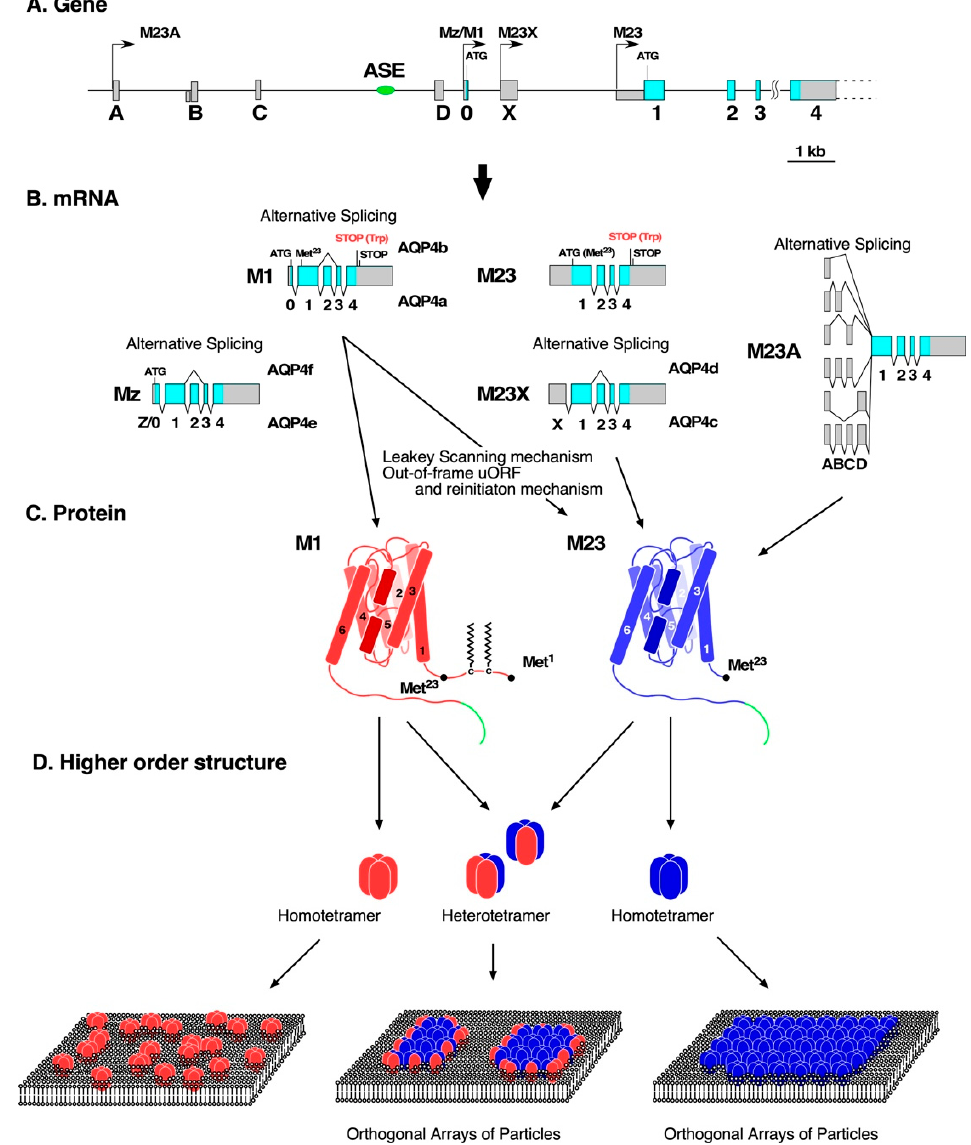
Figure 1. Characteristics of AQP4 expression, translation, and expression on the cell surface. ( A ) A schematic illustration of structure of the AQP4 gene. Transcriptional start sites are indicated with arrows. Exons are represented by boxes. Cording and non-cording regions are indicated in blue and gray, respectively. ( B ) Schematic illustrations of structure of mRNA encoding AQP4. Cording and non-cording regions are indicated in blue and gray, respectively. ( C ) Conformation of M1 (red) and M23 (blue) monomers. A region added to the C terminus of each isoform as a result of transcriptional read-through is represented as a green line. ( D ) Higher-order structures of AQP4; M1 and M23 are indicated in red and blue, respectively.